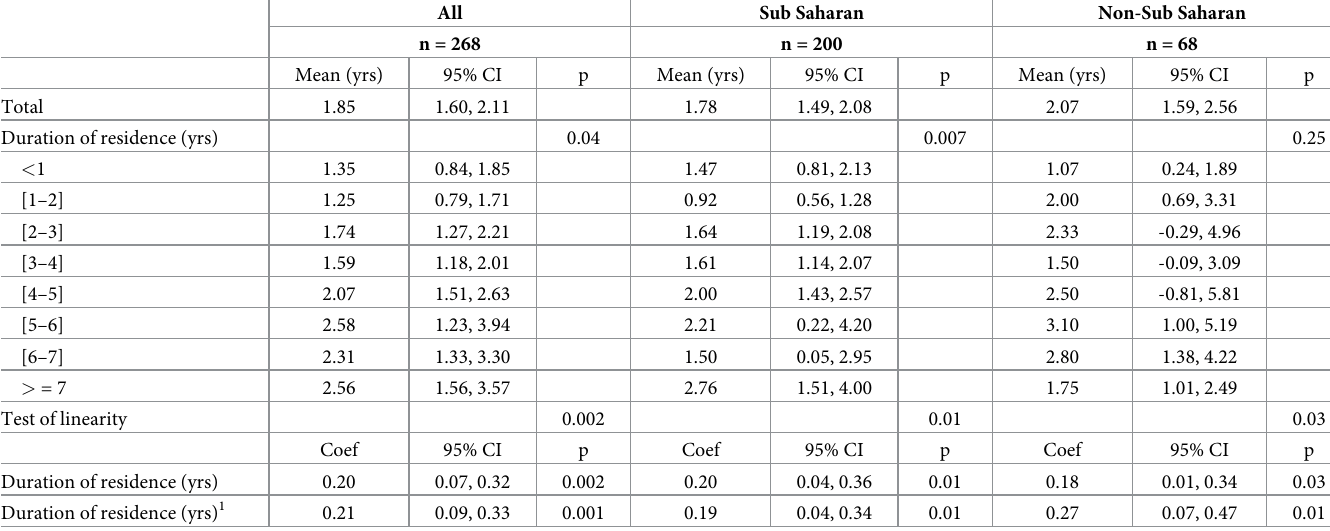
Table 4. Mean time since last HIV test (in years), bivariate and multivariate linear regression, by region of origin, DSAFHIR